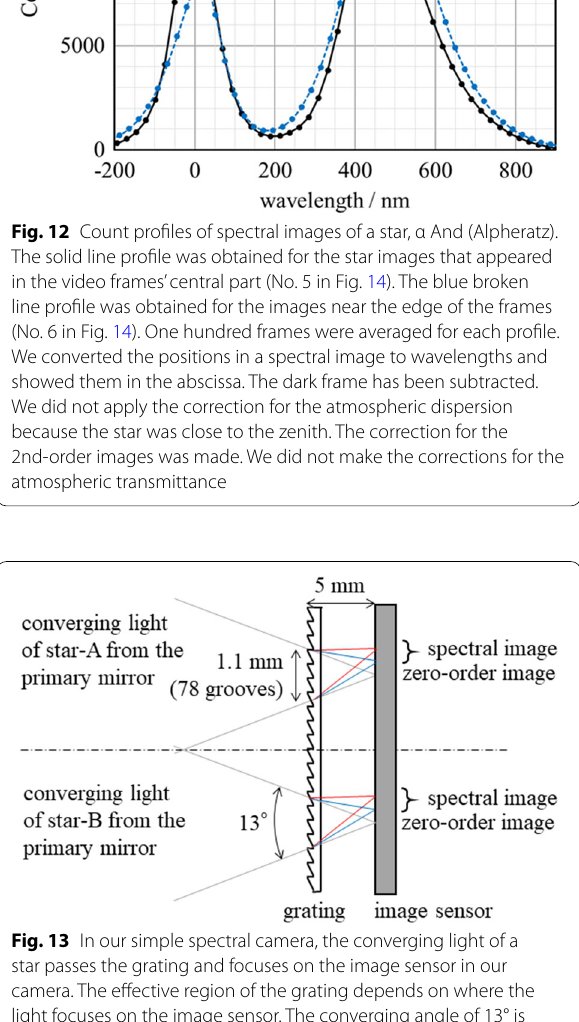
The best-fitted blackbody temperature for TYC652- 390-1, the comparison star for Flash 170204b, is 7600 K, index (Table 3). This star’s spectrum may be approxi- mated by a blackbody spectrum of the temperature higher than 5855 K; that is, we might underestimate the (cid:31) ) temperature of B T star ( in Eq. (14). Then, the derivation of the spectrum of Flash 170204b could lead to a redder spectrum than the real one.